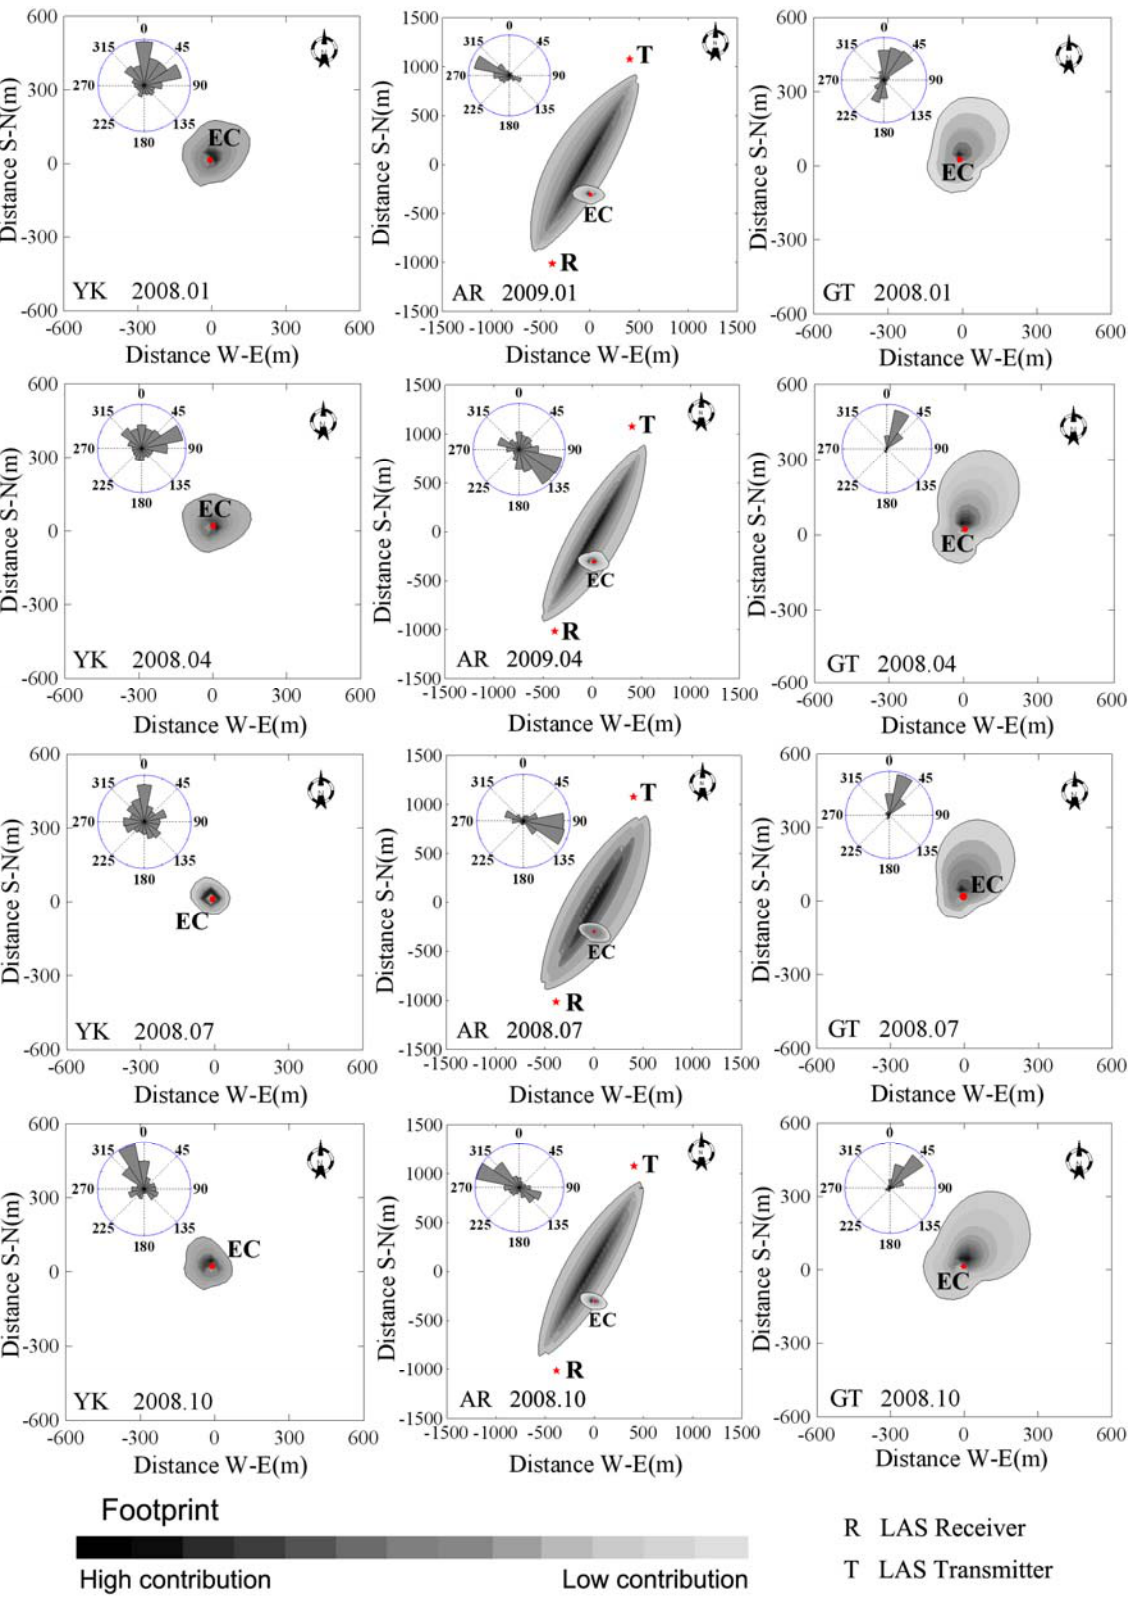
Fig. 3. Source areas of the LAS and EC measurements at the different sites (the source area of 80% contribution to the measured fluxes).